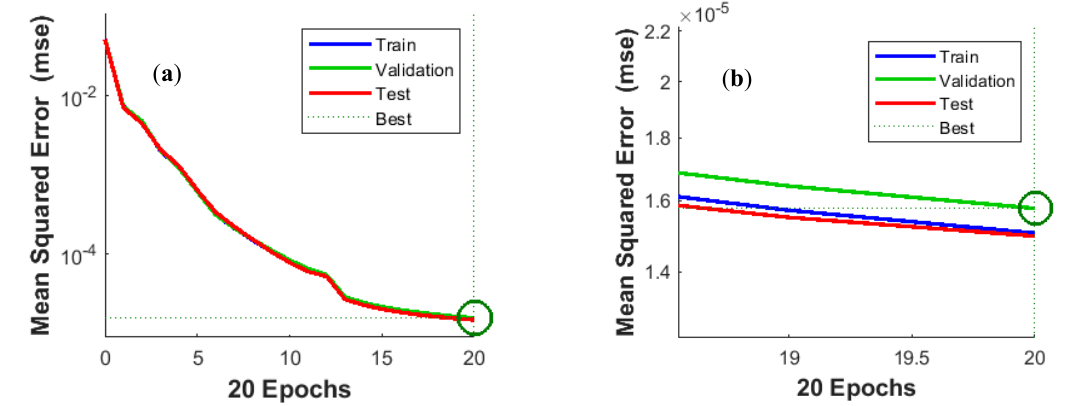
Figure 8. Best validation performance is 1.5775 × 10 − 5 at epoch 20: ( a ) general view, ( b ) enlarged view of the terminal part of the curve.